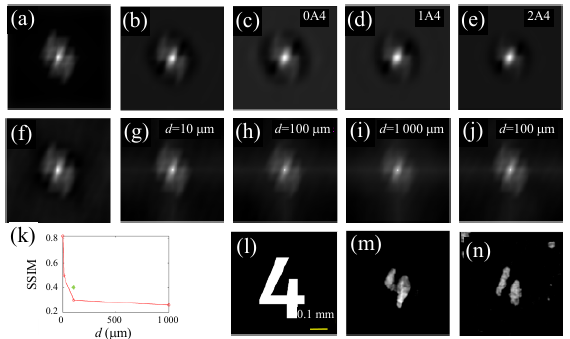
Fig. 6 Experimental and simulated results of single- and dual-pinhole channels to transmit information: (a) the autocorrelation of the target; (b)–(e) the speckle autocorrelation of the prepared scattering media, i.e., a single diffuser, dual diffusers with 0, 1 and 2 A4 paper circles as the spacer, respectively; (f)–(i) the normalized speckle autocorrelation of a single phasemask, dual phasemasks with intervals of 10  m, 100  m, and 1 000  m, respectively. As the interval increases, the distortion of the edge increases; (j) the speckle autocorrelation with 100  m interval when 0.18% ballistic, i.e., zero frequency component is added to the spatial power spectrum density of the first phasemask; (k) the structural similarity (SSIM) of simulated autocorrelations with the autocorrelation of object itself. With increased single channels to transmit information, the SSIM value increases at the same interval of d =100  m, as denoted by the green diamond marker; (l) the photograph of the target with a scale bar of 100  m; (m) the reconstructed image from the speckle pattern obtained in experiment at d =100  m; (n) the reconstructed image from corresponding simulation